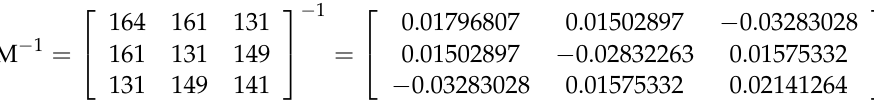
Each color corresponds to one among six patients